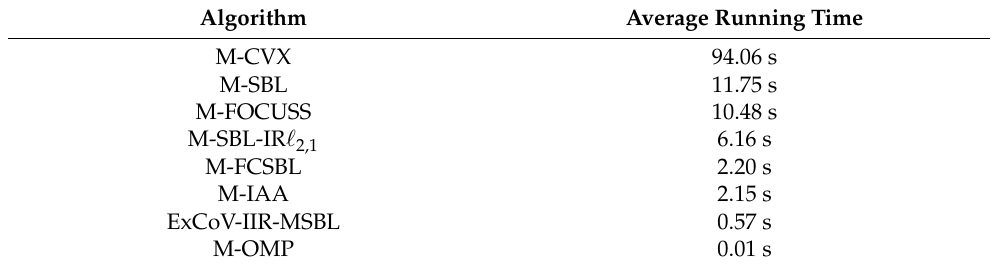
Table 3. Running Time Comparison.